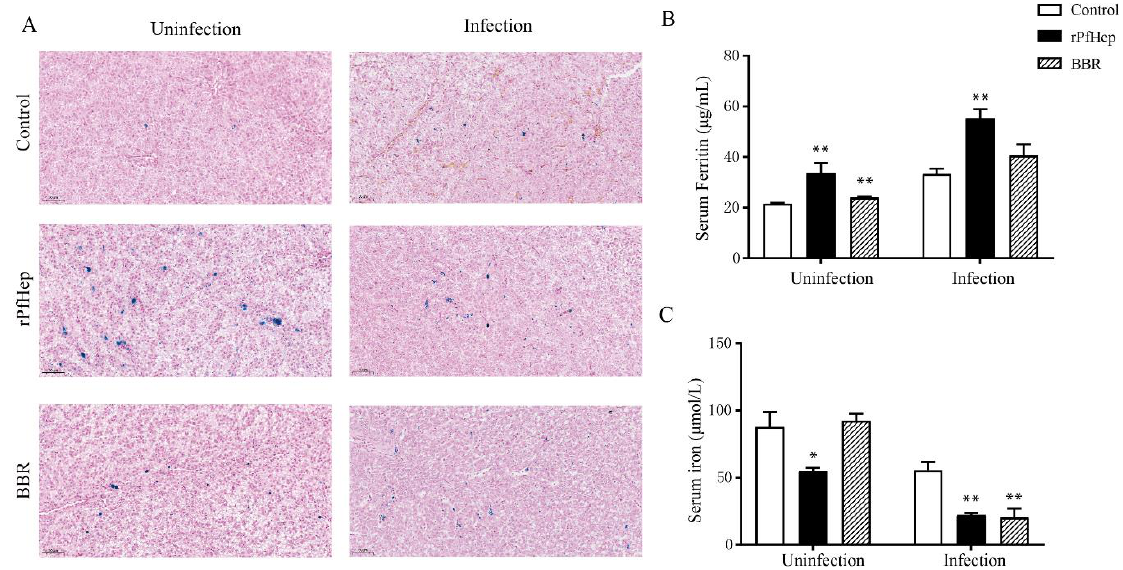
Figure 6. Regulation of liver iron and serum iron levels by rPfHep and BBR. ( A ) The left side is the liver section before infection, and the right side is the liver section after infection, perls’ prussian blue staining. ( B ) ELISA of serum ferritin protein level of yellow catfish. ( C ) Detection of serum iron level of yellow catfish with Nanjing built serum iron test kit. * p < 0.05; ** p < 0.01 versus control.